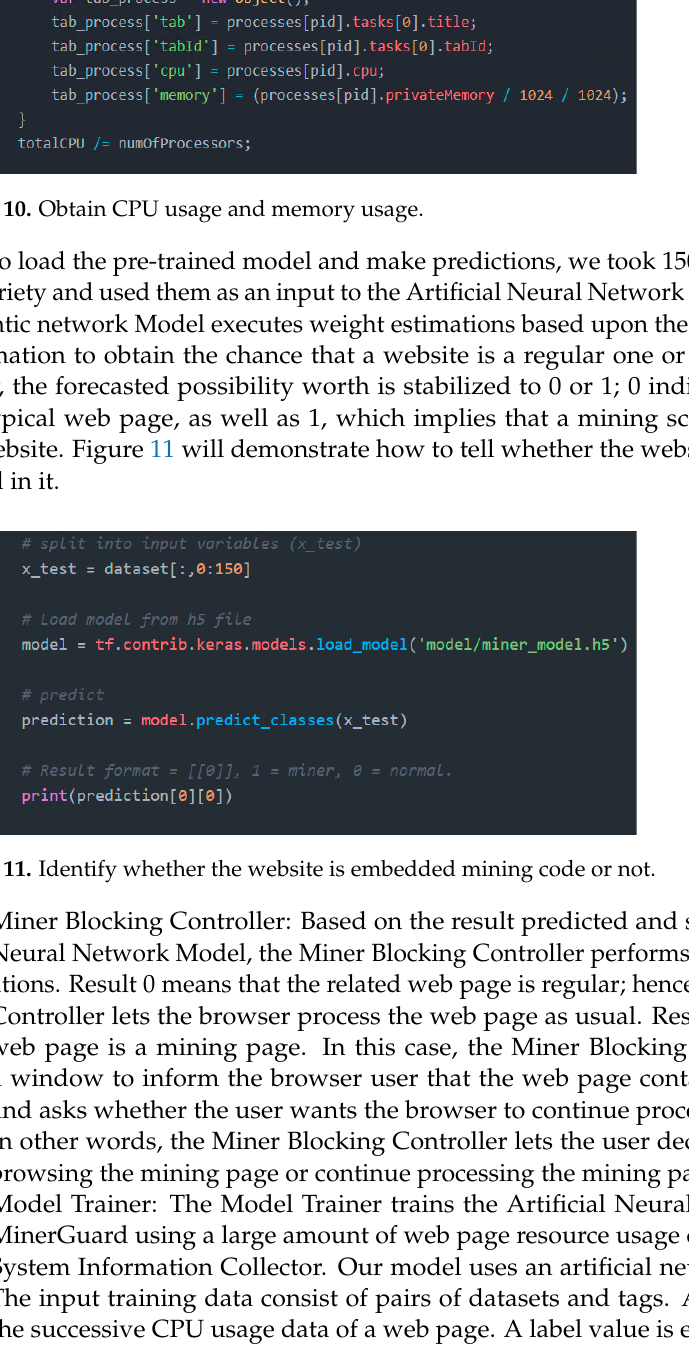
Figure 11. Identify whether the website is embedded mining code or not.